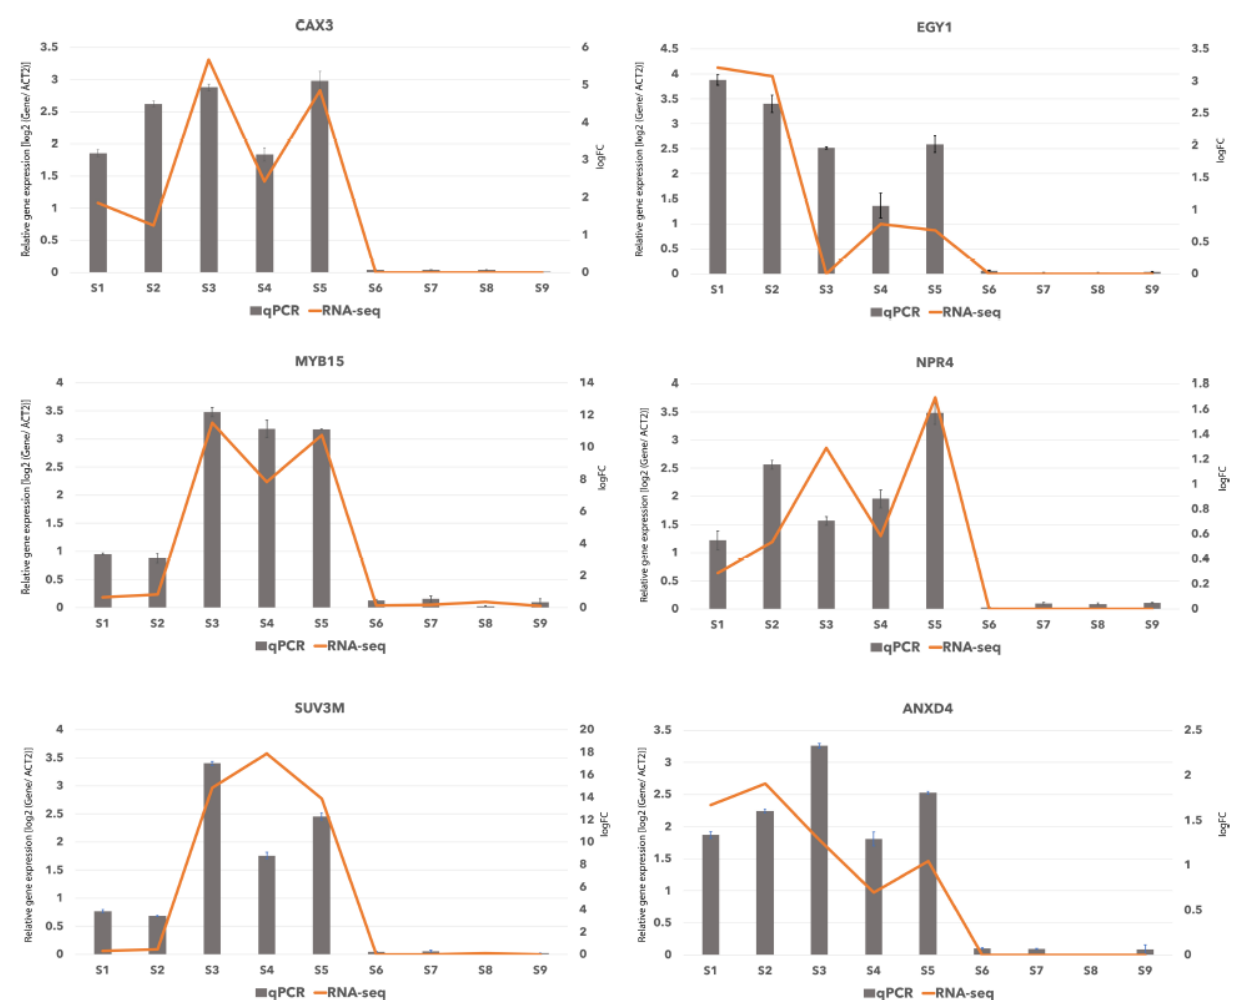
Figure 5. Verification of RNA-seq results by real-time quantitative PCR. Log 2 value of the gene expression in oceanside/riverside for six selected genes. RNA-Seq results -log fold change (logFC)- are shown as bars and qRT-PCR results are shown as lines for relative gene expression [log 2 (Gene/ACT2)].